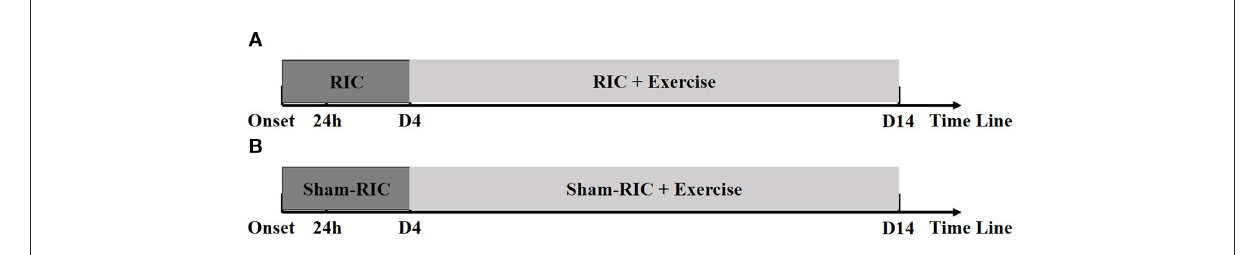
Physicians monitored patients for